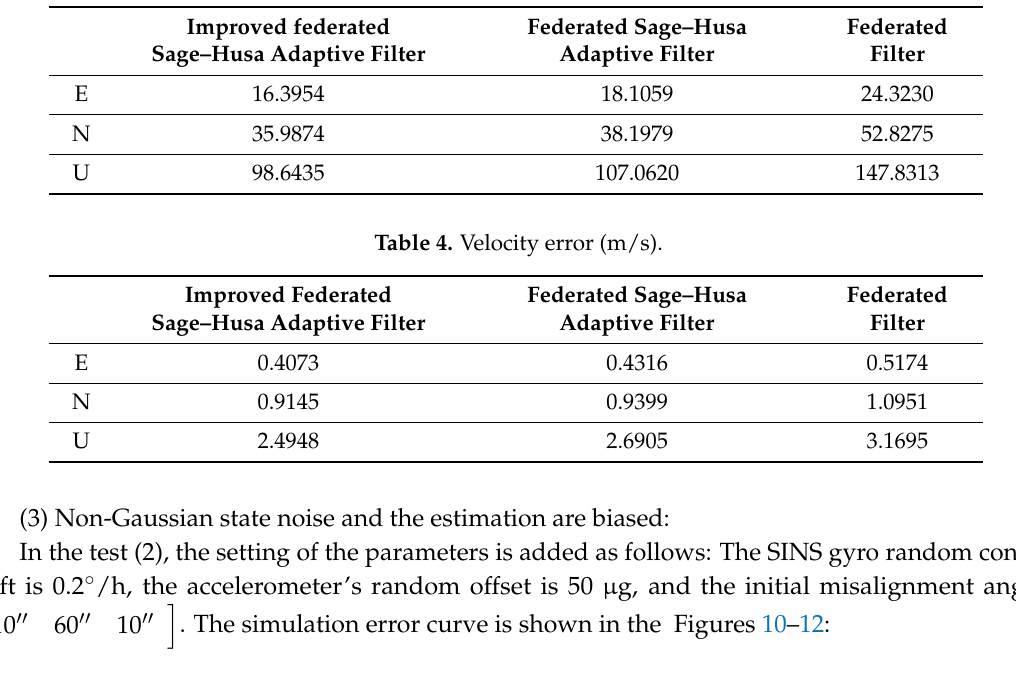
Figure 9. Comparison of the navigation error with Gaussian state noise and biased estimation in U direction. Table 3. Position error (m).